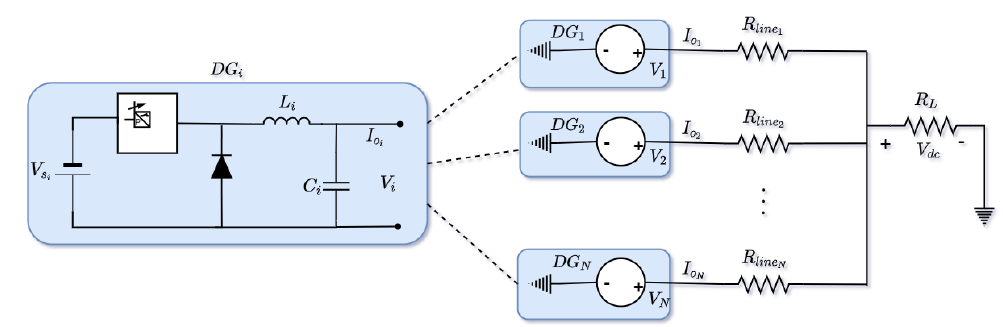
Figure 1. Power system model of a DC